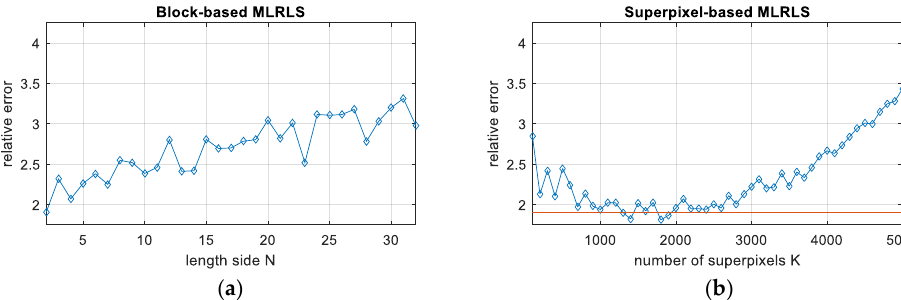
Figure 4. The relative errors of the SD noise: (<a>) the block-based MLRLS (multiple linear regression and least-squares method) and (<b>) the superpixel-based MLRLS. .